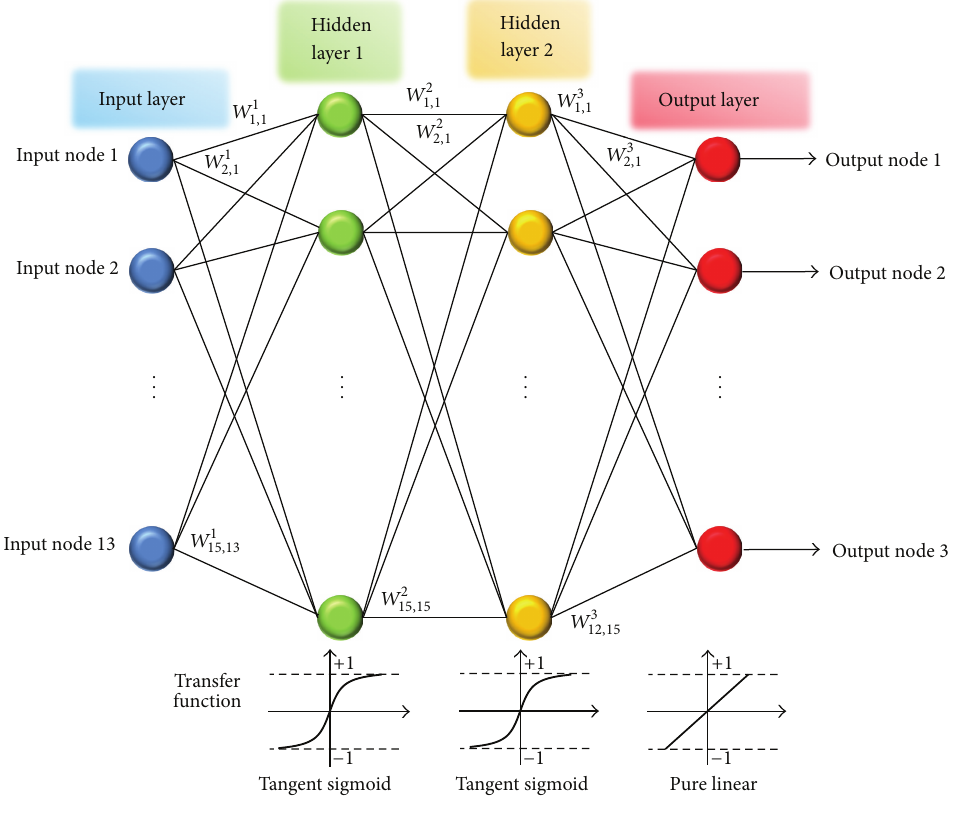
Figure 2: Neural network structure.